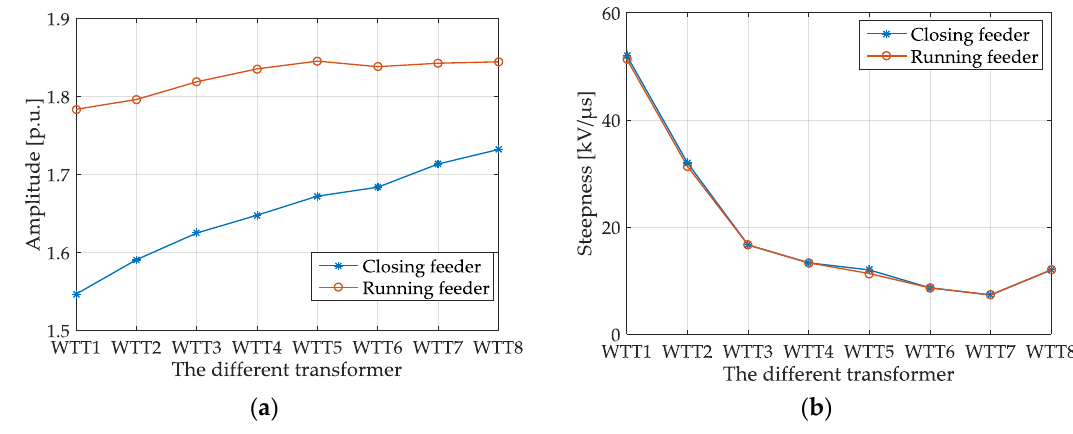
Figure 11. The overvoltage of different transformer locations for Scenario 3: ( a ) amplitude; ( b ) steepness.